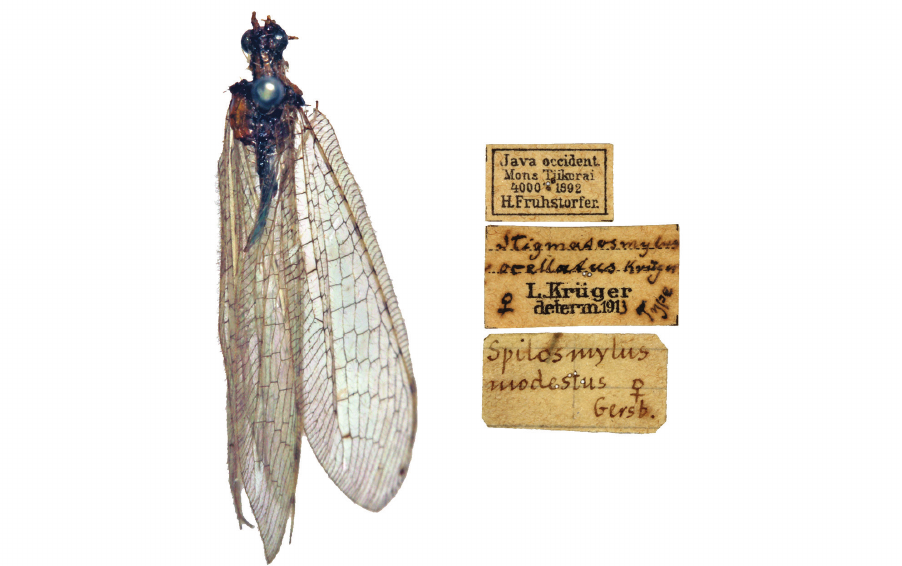
Figure 5. Spilosmylus ocellatus (Krüger, 1914), holotype, habitus and labels (Natural History Museum,